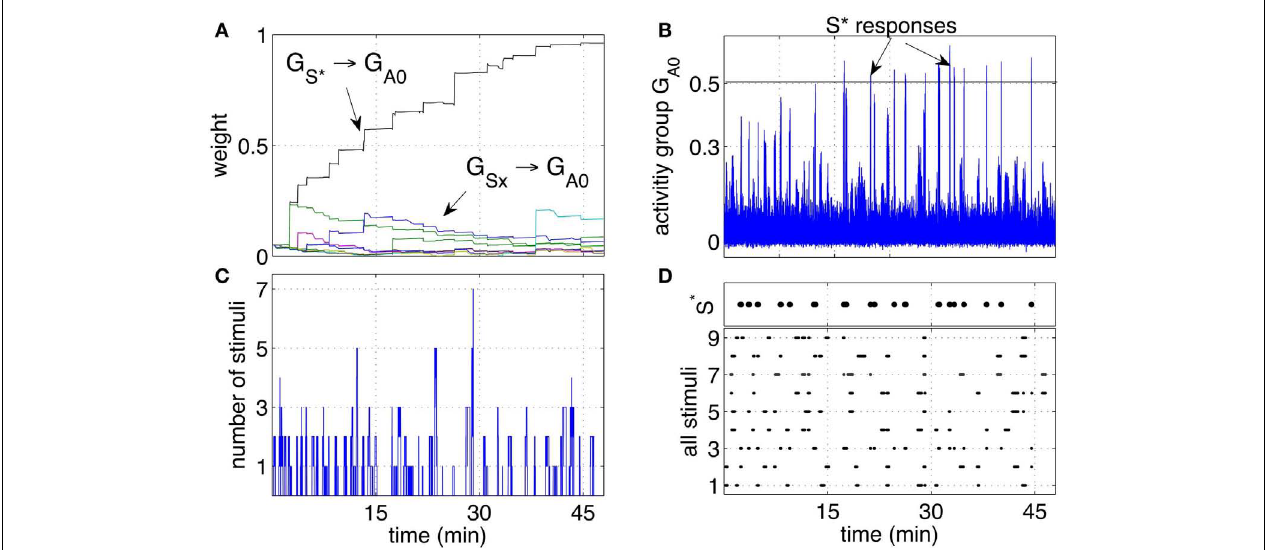
learnt responses to the stimulus S ∗ . (C) Number of simultaneous stimuli present at any time.The plot shows that at times the network receives many stimuli simultaneously, making it difficult to detect which stimulus is causing a reward. (D) The presence of all the stimuli S 1 ..S 9 and S ∗ is plotted to show the correspondence of the arrival of S ∗ with the peaks of the neural activity (B)